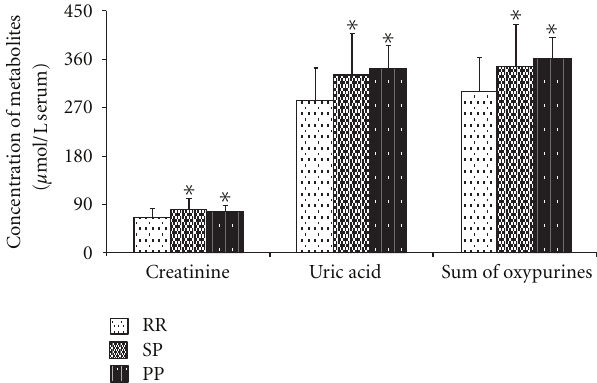
Figure 2: Bar graph showing the mean values of creatinine, uric acid, and sum of oxypurines (uric acid + hypoxanthine + xanthine) in the 170 MS patients divided on the basis of the clinical MS subtype. RR: relapsing remitting; SP: secondary progressive; PP: primary progressive. Standard deviations are indicated by vertical bars. Asterisk = significantly di ff erent from RR ( P < .